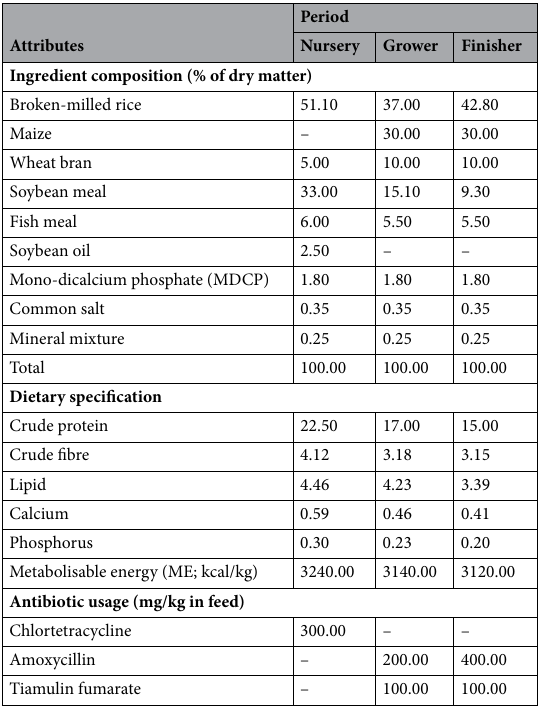
Table 3. Ingredient composition and dietary specification of the experimental basal diet and the antibiotic usage for the antibiotic